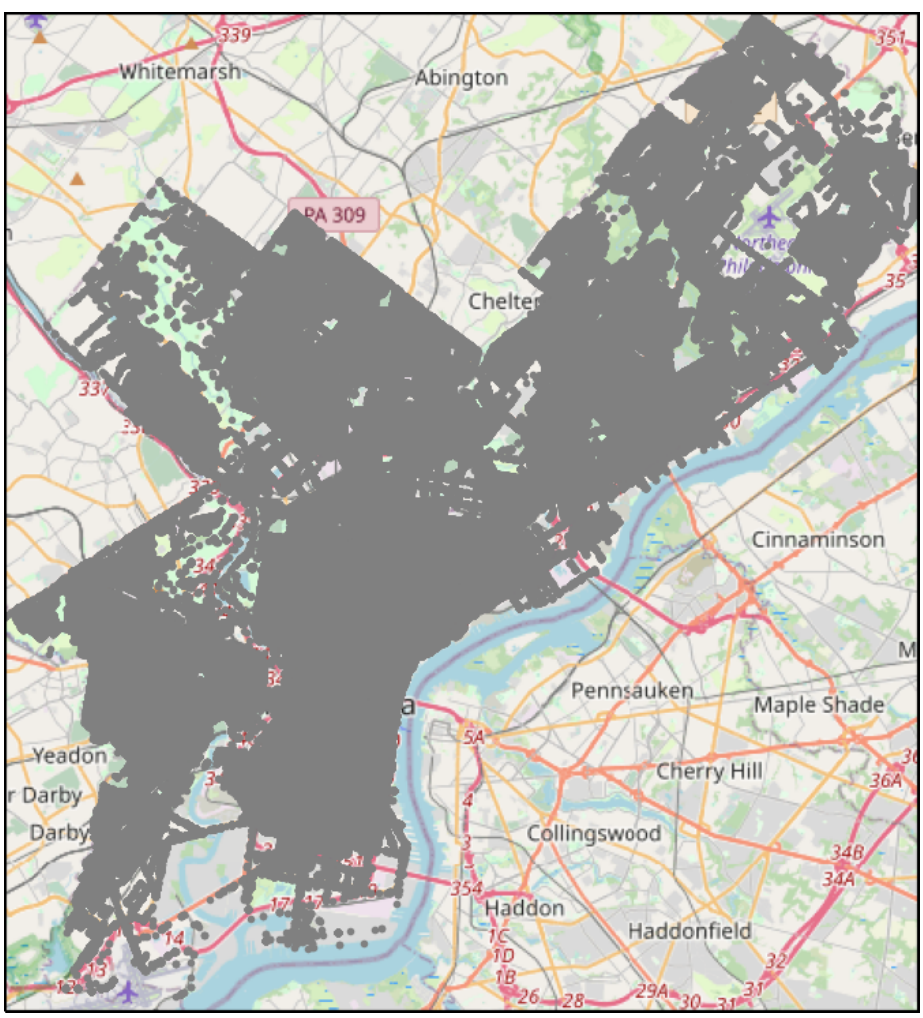
Figure 3. Philadelphia map overlayed with a plotting of all incidents that occurred in 2006. The spatial resolution of all datasets is enough for a block-level analysis of